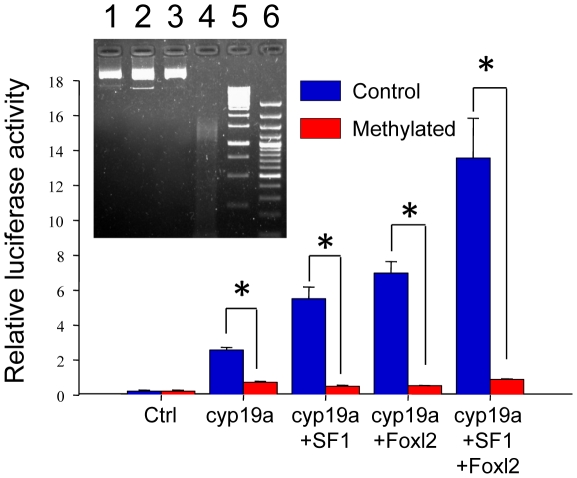
Effects of methylation on sea bass cyp19a promoter activity in vitro.HEK293T cells were transfected with pGL3-cyp19a methylated and unmethylated promoter vectors. Transcription factors SF1 and Foxl2 were cotransfected with the sb cyp19a promoter to activate promoter luciferase activity. Transfected methylated and unmethylated groups were as follows (see Materials and Methods for amounts used): 1) plasmid β-galactosidase (Ctrl); 2) sb cyp19a promoter cloned into pGL3-basic luciferase reporter plasmid (cyp19a); 3) sb cyp19a and tilapia SF1 cloned into pCDNA3.1 expression plasmid (cyp19a+SF1); 4) sb cyp19a and tilapia Foxl2 cloned into pCDNA3.1 expression plasmid (cyp19a+Foxl2); 5) sb cyp19a, tilapia SF1 and Foxl2 cloned into pCDNA3.1 (cyp19a+SF1+Foxl2). The Student's t-test was used to compare methylated and unmethylated vectors. Significant differences are denoted by an asterisk and were as follows: cyp19a, P = 0.006; cyp19a+SF1, P = 0.006; cyp19a+Foxl2, P = 0.003; cyp19a+SF1+Foxl2, P = 0.013. Also, SF1 and Foxl2 exhibited an additive effect since the activation of sb cyp19a promoter was significantly higher when both were transfected together. Values are shown as mean ± S.E.M. (n = 2–4). Insert: Successful vector methylation verification by analysis of band patterns on electrophoresis gel after digestion of the purified plasmids with the McrBC enzyme. Lane 1, 0.5 µg sb cyp19a-pGL3; lane 2, 0.5 µg sb cyp19a-pGL3 treated with McrBC; lane 3, 0.5 µg SssI-methylated sb cyp19a-pGL3; lane 4, 0.5 µg SssI-methylated sb cyp19a-pGL3 treated with McrBC; lane 5, 1 Kb marker; lane 6, 100 bp marker. The electrophoresis gel shows that, as expected, only the methylated vector was digested.